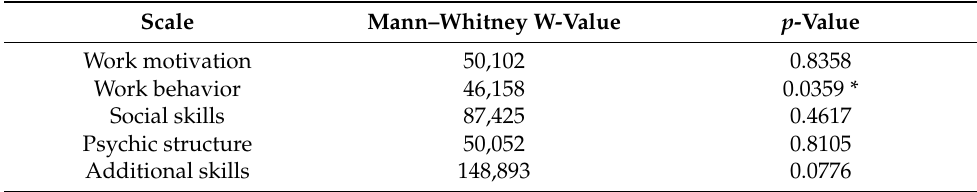
Table 5. Mann–Whitney test statistics when the sample is differentiated by gender.